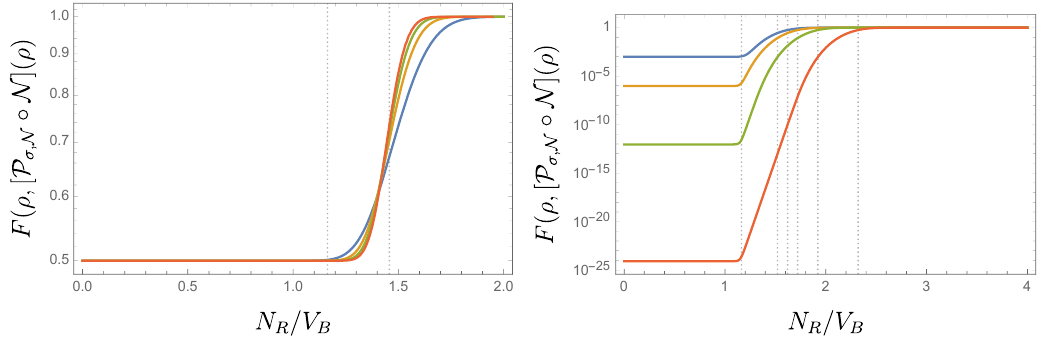
Figure 18 . Left: the fidelity of the Petz recovery map is shown for a diary consisting of a single qubit. The different plots are for different V = 100 , 200 , 300 , and 400 (from blue to red). The transition approaches the second vertical line, which corresponds to t in the thermodynamic limit. p The first vertical line is t . Right: the fidelity of the Petz recovery map for large diaries of sizes b 10, 20, 40, and 80 qubits (top to bottom). The first two vertical lines denote t and t which are b p separated even in the thermodynamic limit. We also display the t ’s for the respective diary sizes, p 2 always with V = 100 . We take R to be at infinite temperature and B 0 to be at finite temperature √ E with Cardy-like density of states ρ ( E ) = e V in both plots, taking β = 1 / 2 . Notably, the fidelity V increases significantly between t and t and does not saturate to one until after t b p p 2